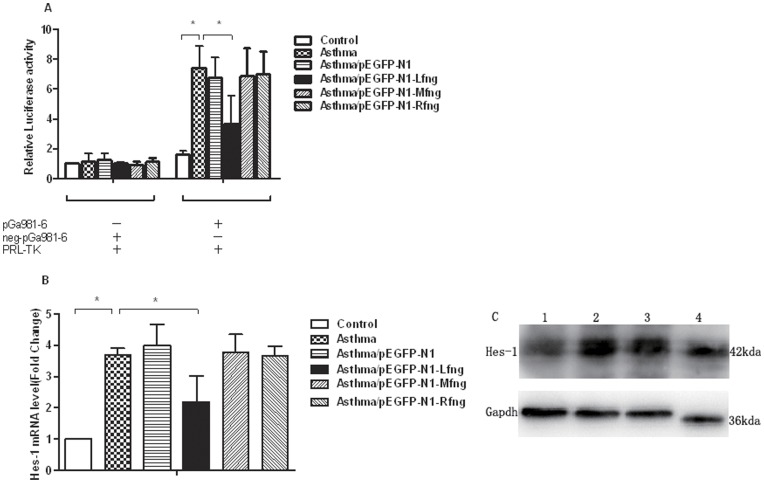
Notch signaling assay in asthmatic naïve CD4+T cells.
A, Asthmatic CD4+T cells were transfected with Lfng plasmid and RBPJ-κ luciferase reporter plasmid pGa981-6. Then the luciferase activities were analyzed and normalized to Renilla luciferase activity in control group, asthmatic group, asthmatic CD4+T cells treated with control vector pEGFP-N1 and asthmatic CD4+T cells treated with Lfng, Mfng or Rfng group. We found that Notch signaling was activated in asthmatic group and overexpression of Lfng led to a reduction in Notch signaling activity. But there was no significant differences in Mfng or Rfng group. The results are shown as mean±SEM from three samples. *p<0.05; **p<0.01. The results are from one representative experiment of three independent experiments. B, Realtime PCR was performed to detect the mRNA levels of Hes-1. The mRNA levels of control CD4+T cells group were taken as 1. Results are from three independent experiments. The data for each group are expressed as means±SEM. *p<0.05, significant differences between asthmatic group with control group, or asthmatic group with asthmatic CD4+T cells transfected with Lfng, Mfng or Rfng group. The Hes-1 mRNA decreased in Lfng group comparing with the asthmatic counterparts, but there was no significant differences in Mfng or Rfng group. C, Hes-1 protein levels in each group. Lane 1, control CD4+T cells; Lane 2, asthmatic CD4+T cells; Lane 3, asthmatic CD4+T cells transfected with pEGFP-N1 plasmid; Lane 4, asthmatic CD4+T cells transfected with Lfng plasmid. Representative of one of three similar experiments. The Hes-1 protein decreased in Lfng treated group.